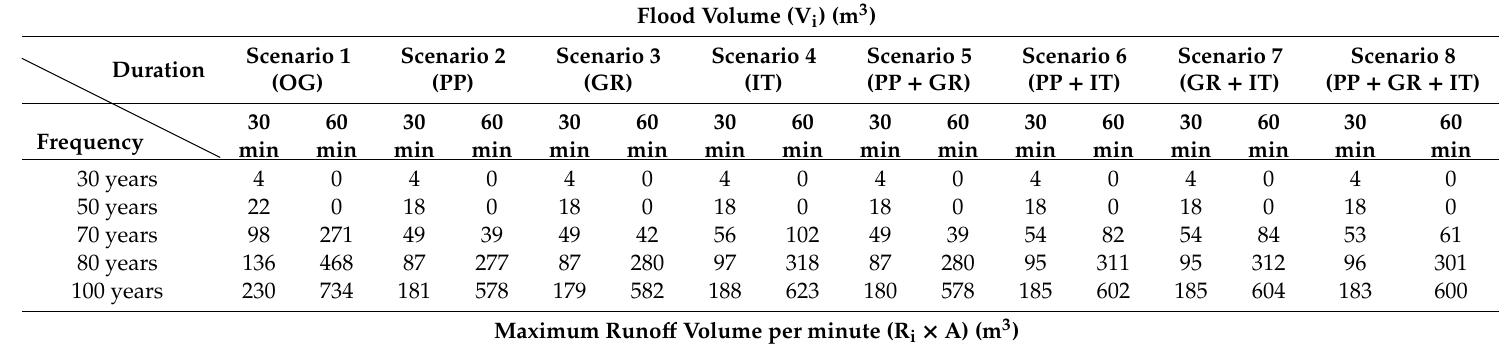
Table 6. Flood volume reliability